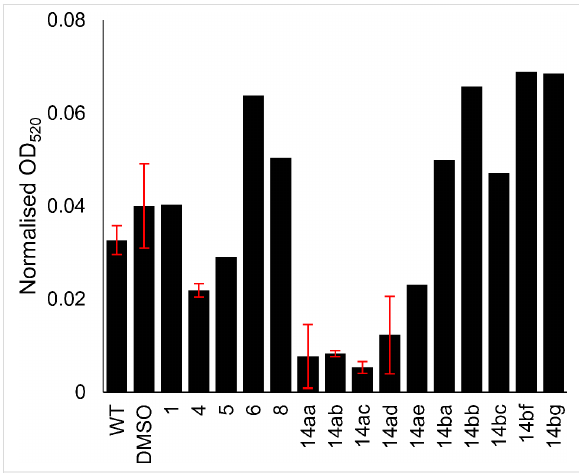
Figure 4: OD 520 (absorption corresponding to pyocyanin) normalised by the culture population (measured by OD 600 ) for cultures of P. aeruginosa PA01 grown in the presence of concentrations of 200 μ M of natural products and analogues after 8 hours. WT = wild type, no treatment added. DMSO = treated with DMSO blank. The ex- periment for 7 was not performed due to lack of material. The most promising results were replicated once to ensure validity, as shown by error